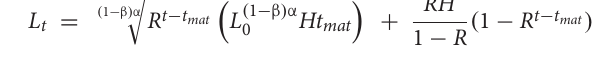
( Table 1 ). Age, weight, and length in the PP morph ( N = 233)